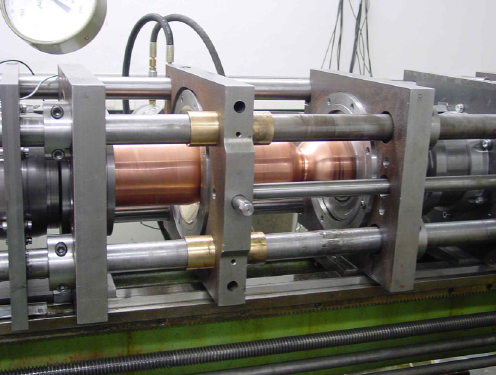
FIG. 9. Central part of DESY necking device.